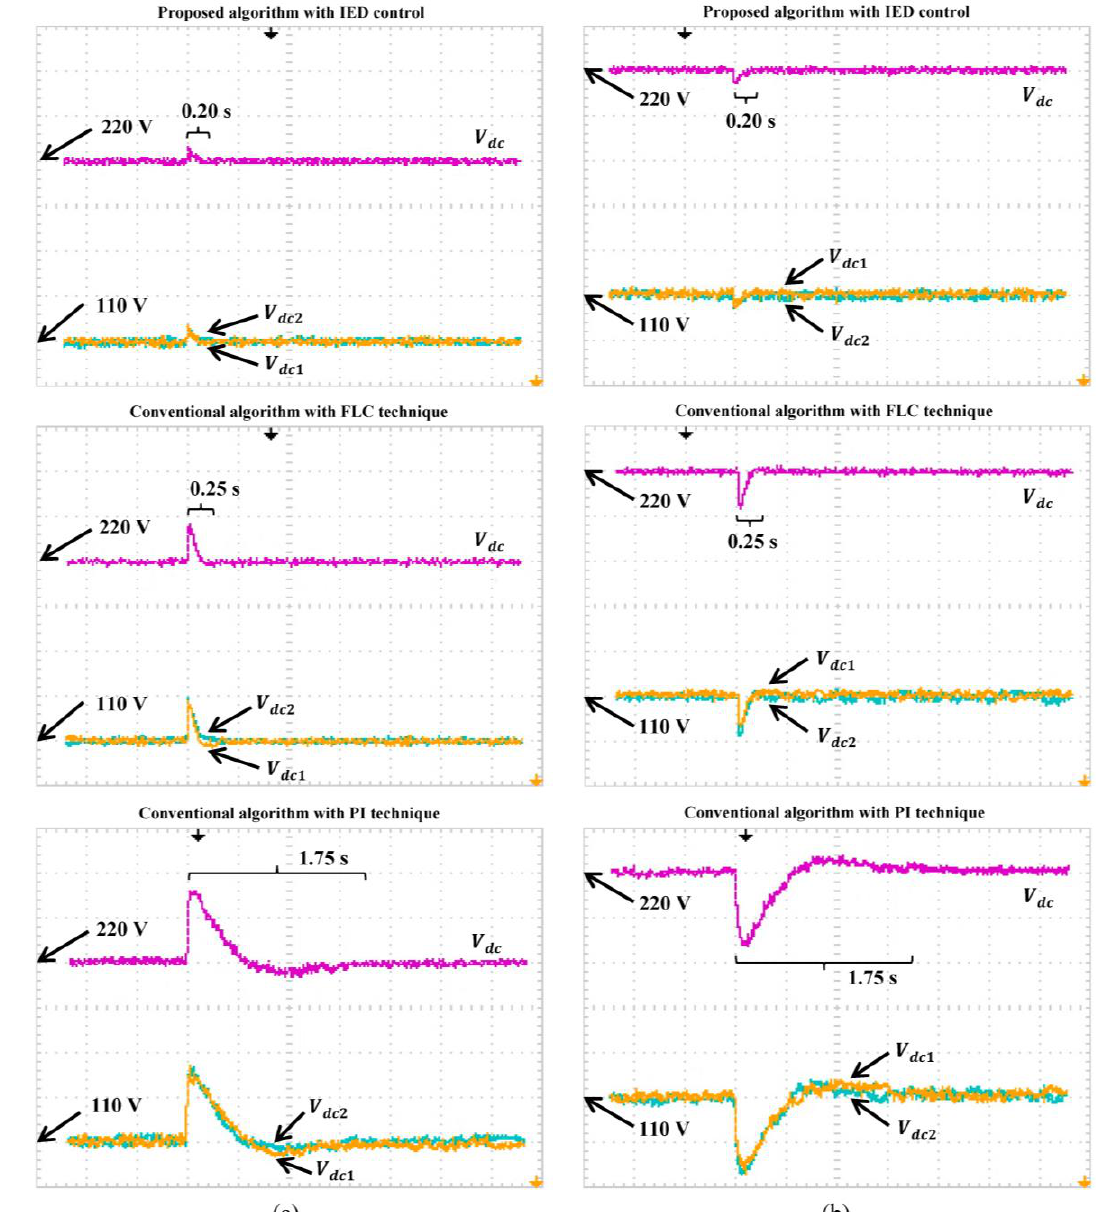
Figure 15. Experimental results of SAPF with different DC-link capacitor voltage regulation algorithms which include overall DC-link voltage 𝑉 𝑑𝑐 (20 V/div), and splitting DC-link capacitor voltages 𝑉 𝑑𝑐1 and 𝑉 𝑑𝑐2 (10 V/div) for dynamic-state conditions of ( a ) capacitive to inductive and ( b ) inductive to resistive loads.